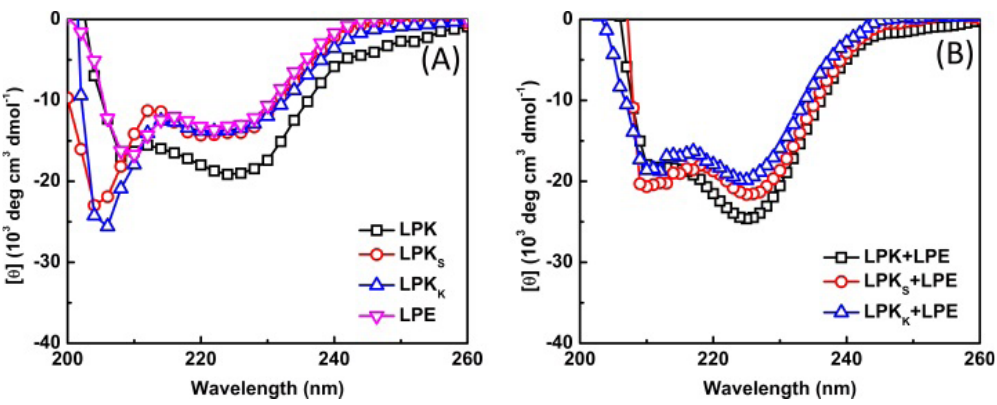
Figure 4: (A) Circular dichroism spectra of 1 mol% lipopeptide on liposomal membranes. (B) Equimolar mixture of LPK (and its derivatives) and LPE on liposomes. [Lipids]=0.5 mM, PBS buffer, pH=7.4, 25 o